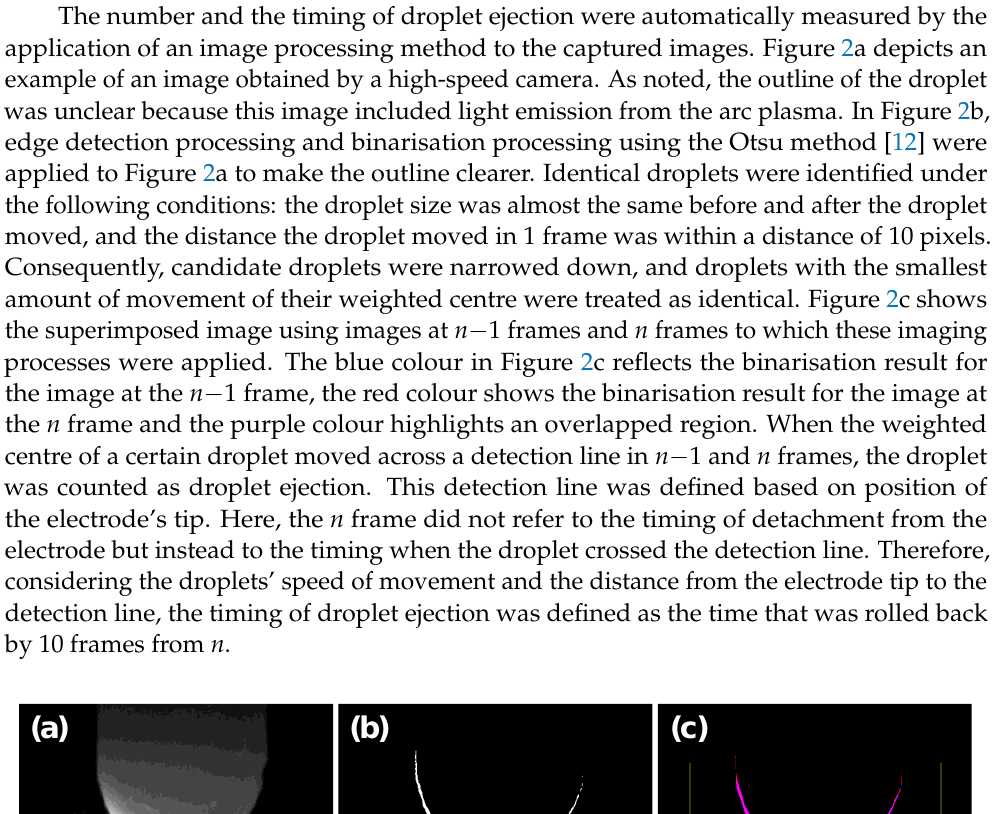
Figure 3. A comparison between the automatic and manual measurements.